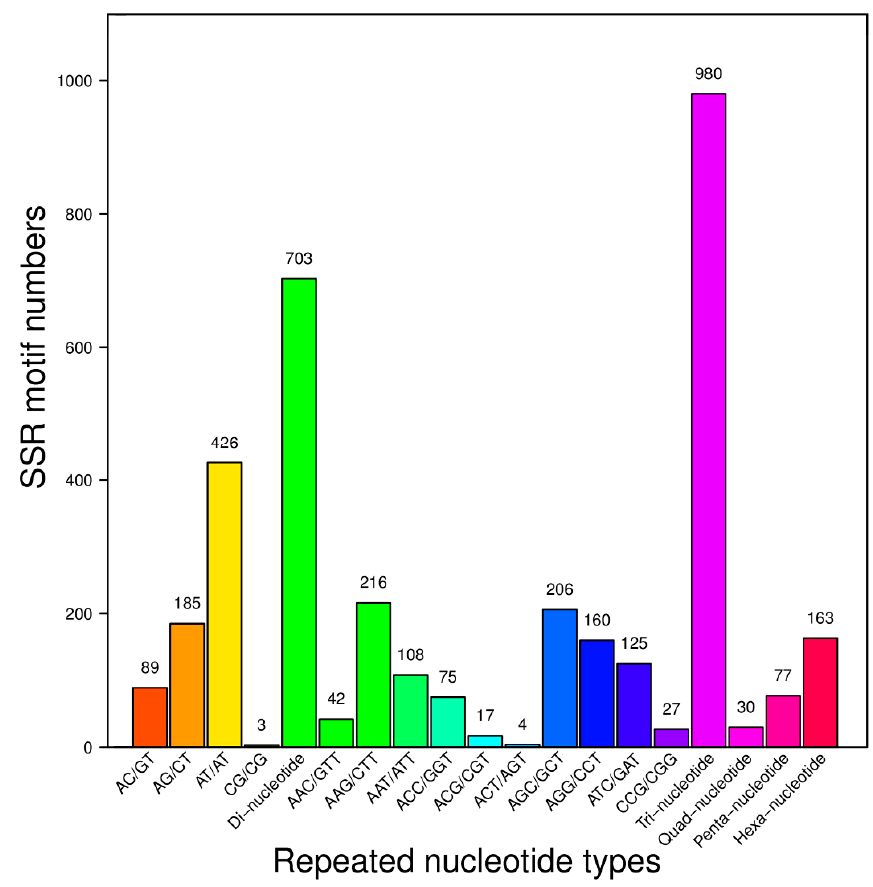
Figure 5. Frequencies of different repeat motifs in the EST-SSRs.